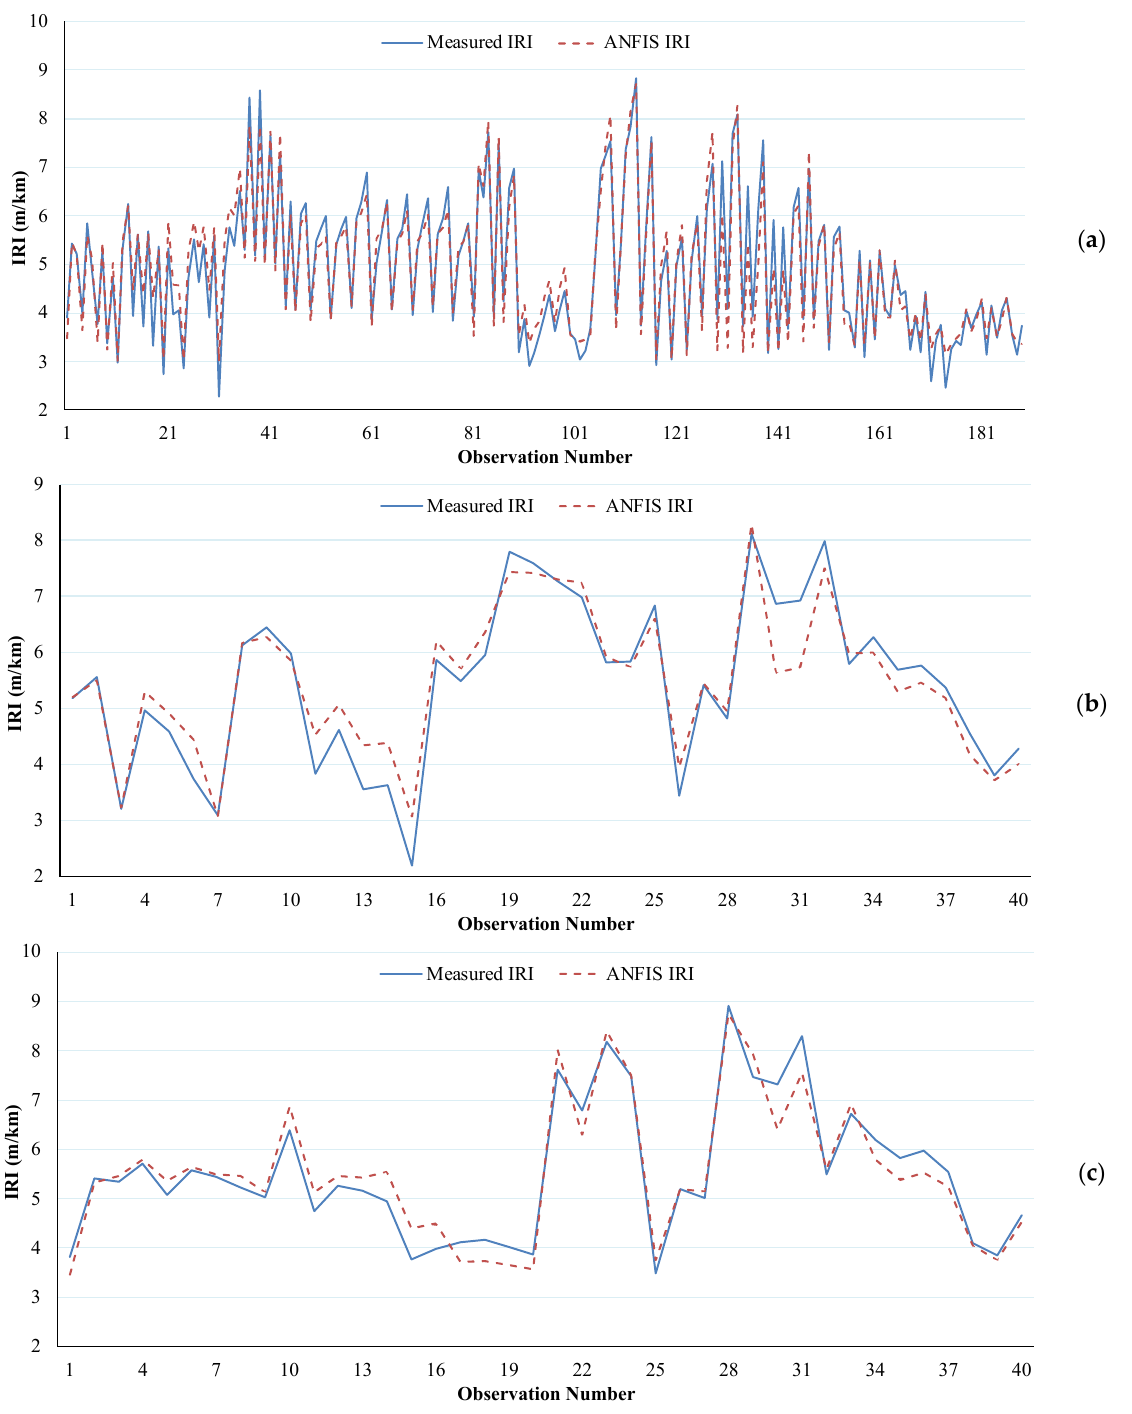
Figure 11. Comparison between the measured and the modeled IRI values of the DBST model for the ( a ) training, ( b ) checking, and ( c ) testing data sets.